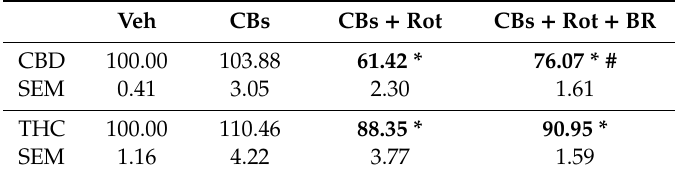
Table 1. Bilirubin increases the metabolic activity of rotenone-stressed N18TG2 cells co-treated with cannabidiol.